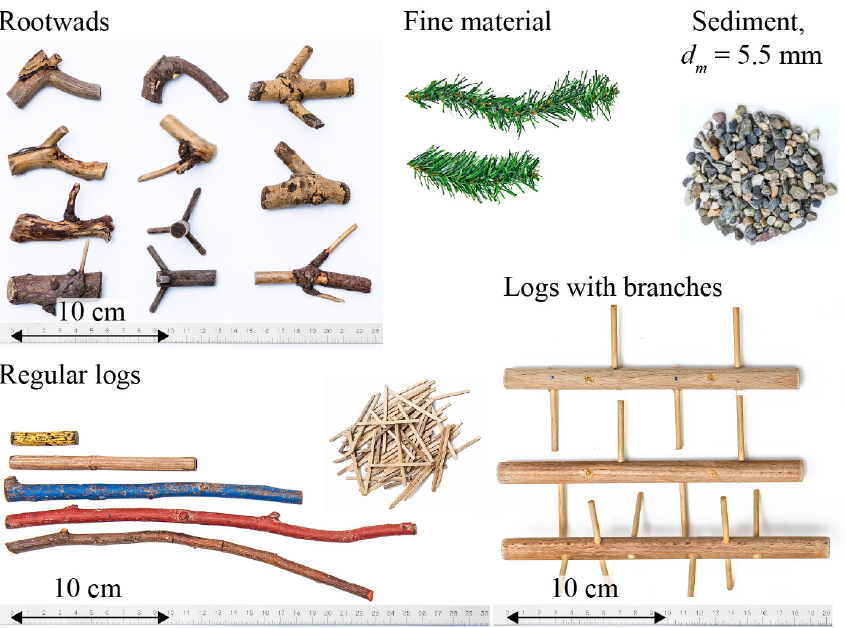
Figure 2. Model wood, fine material, and